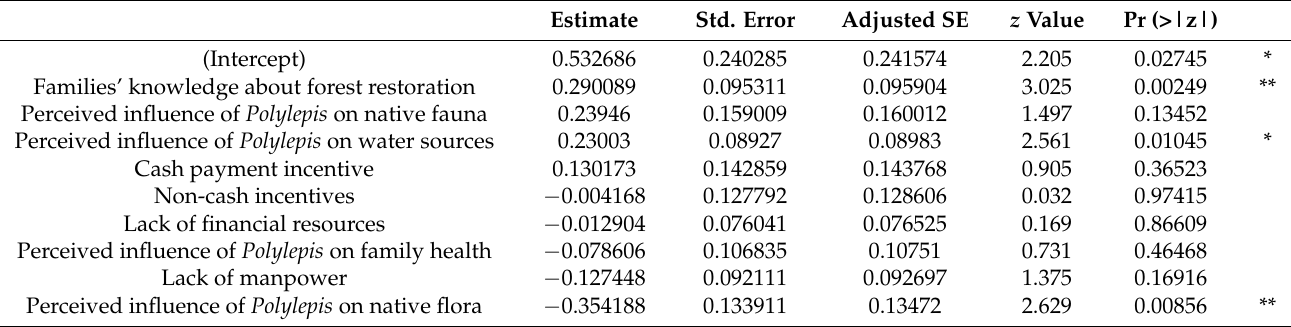
Table A3. Influence of the perception variables of the rural families in the size of the Polylepis forest areas that they intend to restore in the